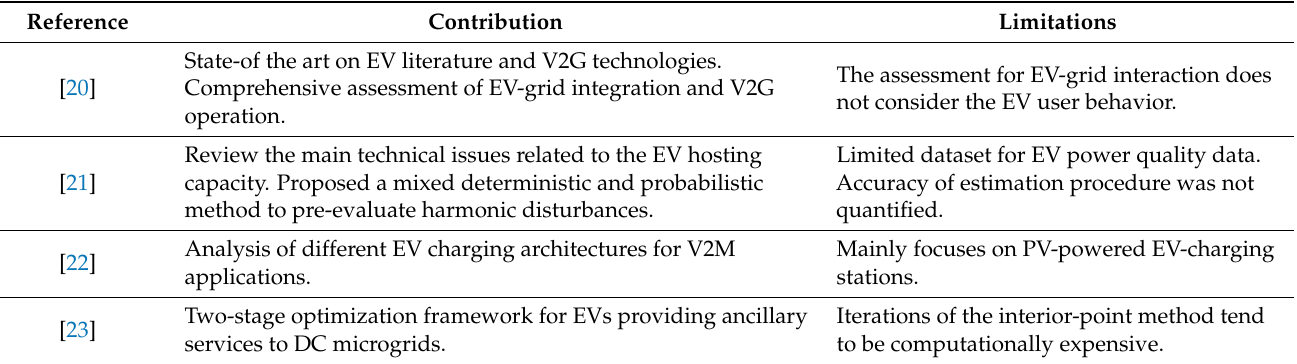
Figure 3. Simplified representation of the V2G and V2M applications. ( a ) Representation of the V2G application. ( b ) Representation of the V2M application. Table 1. Main contributions in recent literature focusing on